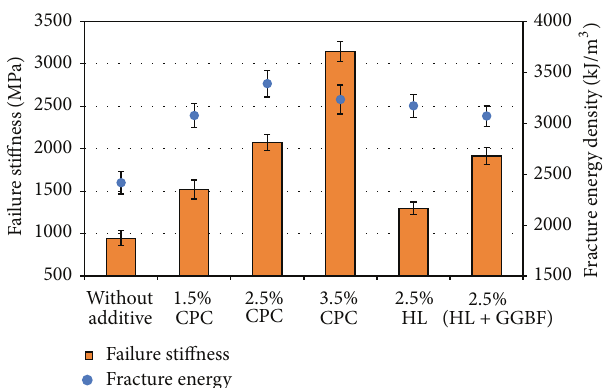
Figure 5: Failure stiffness and fracture energy density.